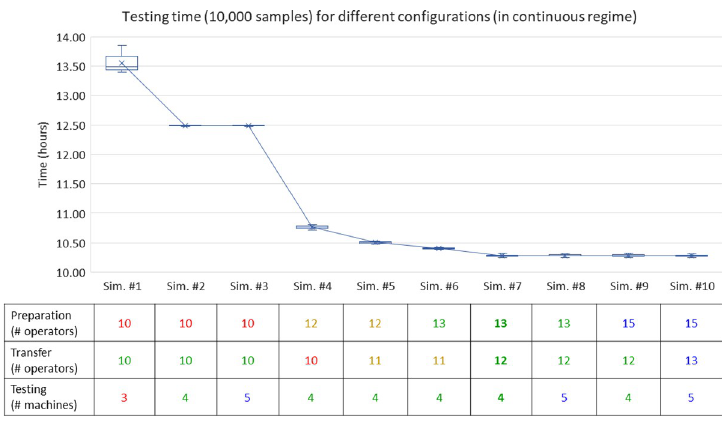
Fig 5. Evaluation of scenarios through simulation runs (in established and continuous